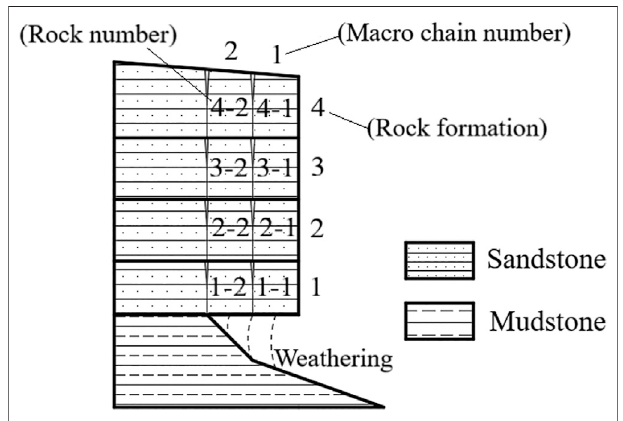
FIGURE 1 | Horizontally layered dangerous rock slope model.